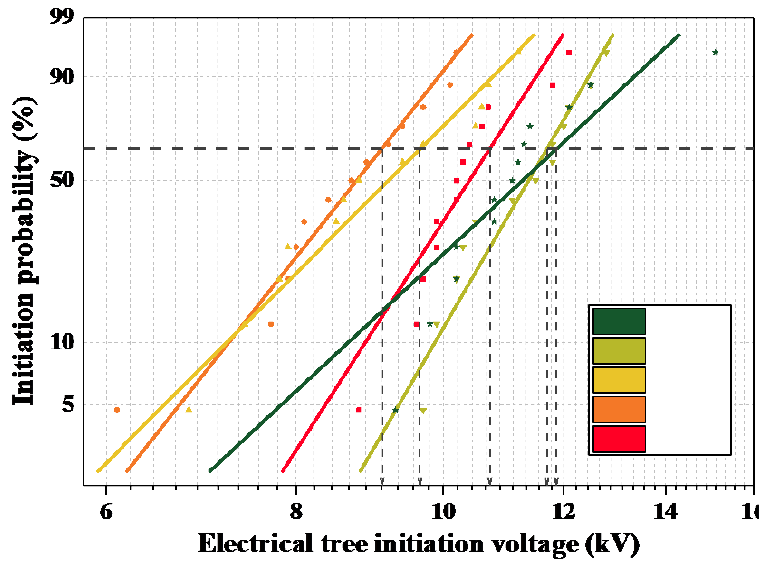
Figure 4. Weibull distribution of electrical tree initiation voltages. Table 1. Initiation voltages and initiation field strengths of electrical trees from different co-mixing